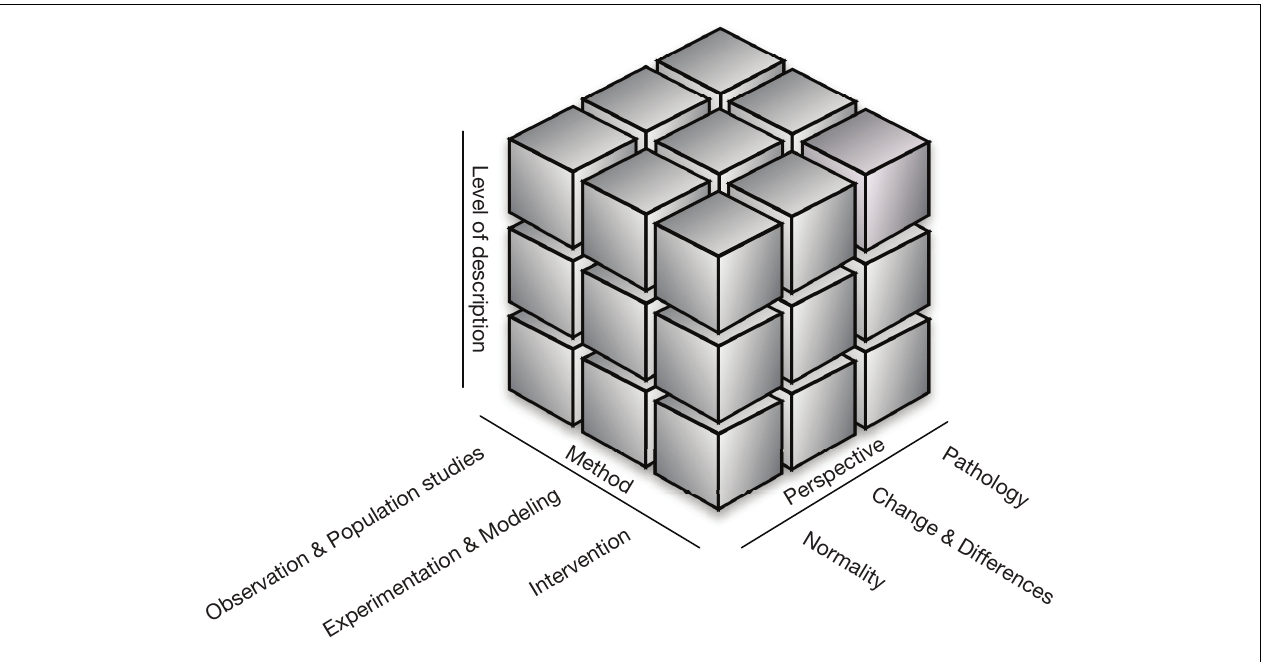
FIGURE 1 | Carving up psychology at its joints results in a Rubik’s Cube of 27 subfi